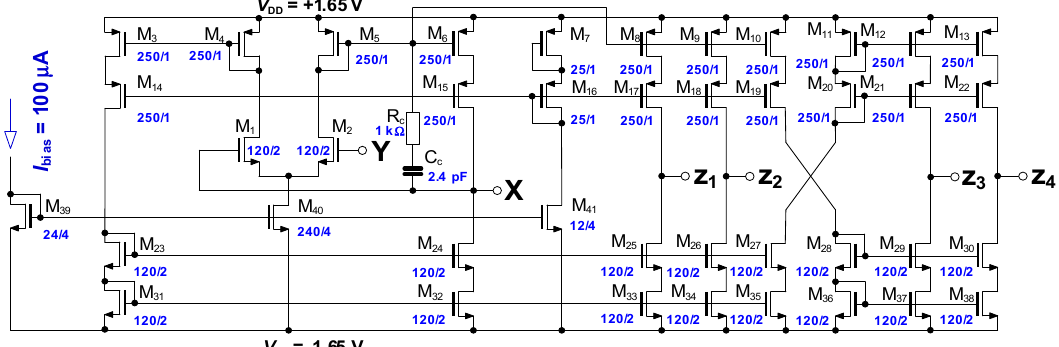
Figure A4. Full CMOS topology of the current-controlled current conveyor of the second generation (CCCII).